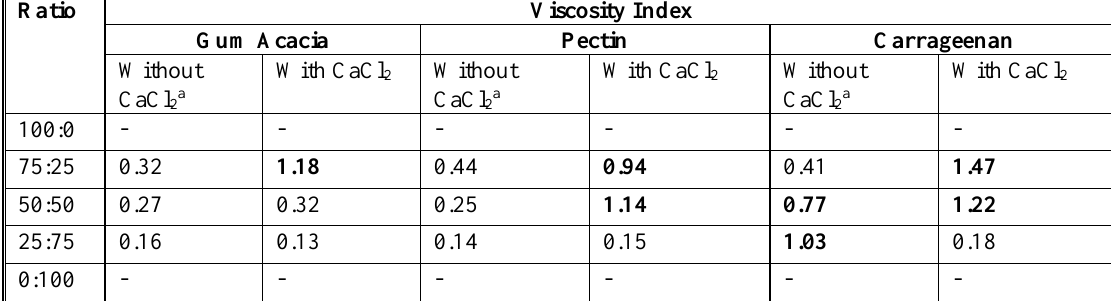
Table 5. Viscous synergism Index of alginate mixture in with and without CaCl 2 Ratio Viscosity Index Gum